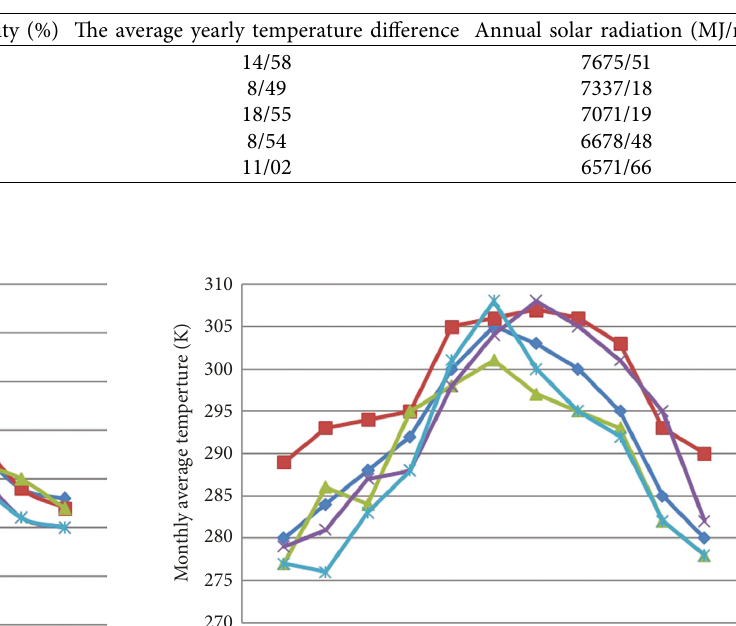
Table 3: Climate and climatic conditions of selected cities.